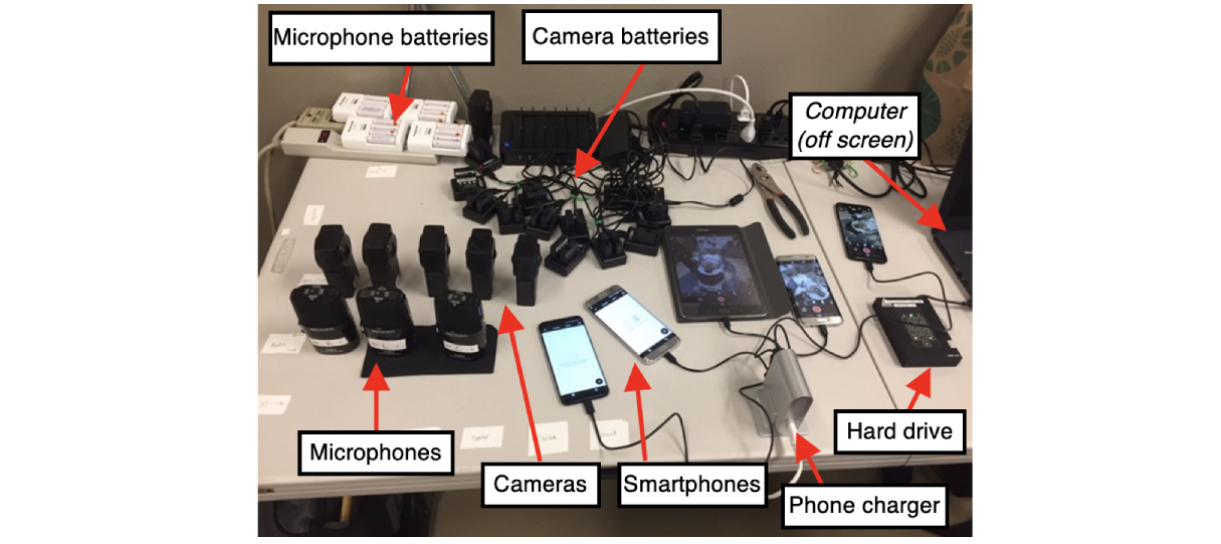
Figure 5. CineVR Control Station, where all equipment was placed during